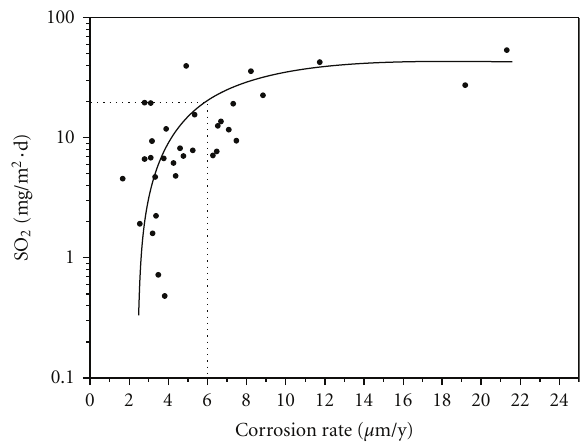
Figure 1: Variation of atmospheric corrosion rate for conventional weathering steel with SO 2 content in the atmosphere, constructed from date provided by UNECE, after 8 years of